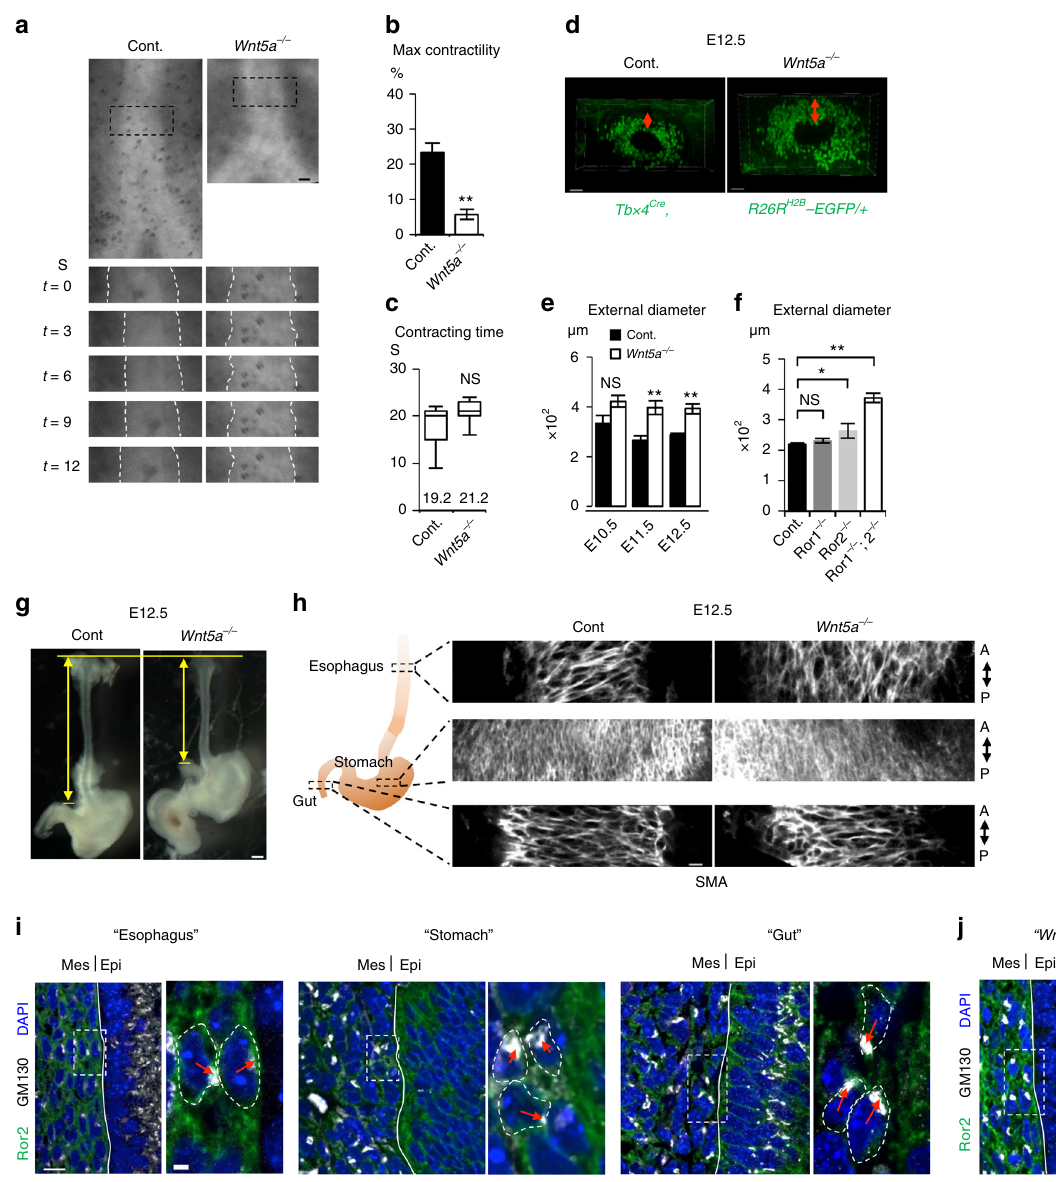
Fig. 5 Wnt5a-Ror2 signaling controls contractility of SM and restricts radial expansion during tube elongation of developing trachea and esophagus. a Representative time-lapse sequence of contractile movement of tracheas. The black-dotted squares in upper are magni fi ed in lower. White-dotted lines indicate epithelium – mesenchyme boundaries. See also Supplementary Movie 5. Maximal contractility ( b ) and contraction time ( c ) in a . Columns represent means ± SEM ( n ≥ 3). Numbers represent means. For box and whisker plot, center line, box limits and whiskers represent mean, 25 and 75% con fi dence limits, and min and max values, respectively. ( d ) Thickness of tracheal mesenchyme in Tbx4 Cre , R26R H2B-EGFP/ + . Transversal views were shown. Red- arrows indicate thickness of mesenchyme. ( e , f ). External diameter of tracheal tube. (Control; n = 4 – 6, Wnt5a − / − ; n = 3, Ror1 − / − = 5, Ror2 − / − = 5, Ror1 − / − ; Ror2 -/- = 3). Each column represents the means±SEM. P values ( * P < 0.05, ** P < 0.01) show the signi fi cance with Student ’ s t test ( b , e ) or the Tukey-Kramer method f . NS not signi fi cant. ( g ) Gross morphology of the esophagus at E12.5. Yellow arrows indicate the length of the esophagus. h SM tissue architecture of digestive organs at E12.5. Whole organs were stained for SMA (white). Coronal sections were shown. A anterior, P posterior. See also Supplementary Movie 6. i , j The polarity of subepithelial cells of digestive organs from wild type ( i ) and Wnt5a − / − ( j ). Ror2 (green), GM130 (white), and DAPI (blue). Dotty squares were magni fi ed in right panels. Lines indicate boundaries between epithelium and mesenchyme. Red arrow indicates the position of Golgi-apparatus relative to nuclei. Scale bar; 50 μ m ( d ), 20 μ m ( h ), 10 μ m ( e , i , j ; left), 2 μ m ( i , j ; right panels) mediated by Wnt5a-Ror2 is critical for tube elongation of the a short-tube phenotype (Fig. 5g and Supplementary Movie 6). stomach, duodenum, and intestine 29,30 . We con fi rmed that Ror2 These observations suggested that the mechanism in which Wnt5a-Ror2 signaling promotes long, straight tube was expressed in the epithelium of the stomach and gut but not morphogenesis is conserved. In contrast, in the gut, the in the trachea or esophagus (Supplementary Fig. 10). Thus, different mechanisms are likely to be involved in the mesenchyme exhibited randomized polarization in normal tube elongation in the trachea and esophagus vs. the stomach embryos, and Wnt5a − / − embryos showed no SM morphology phenotype (Fig. 5h). It is reported that epithelial-cell intercalation and gut. NATURE COMMUNICATIONS| (2018) 9:2816 |DOI: